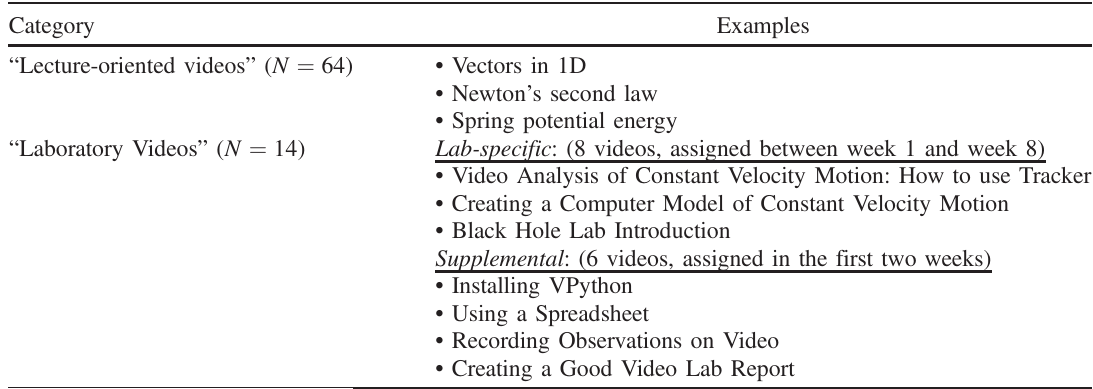
TABLE I. Examples of videos in each category.